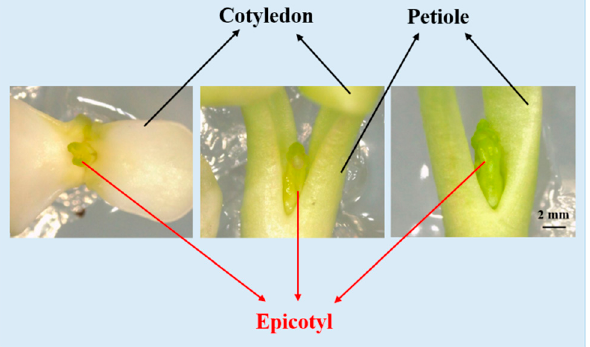
Figure 1 . The structure of embryos viewed as losing the epicotyl dormancy. The scale bar is 2